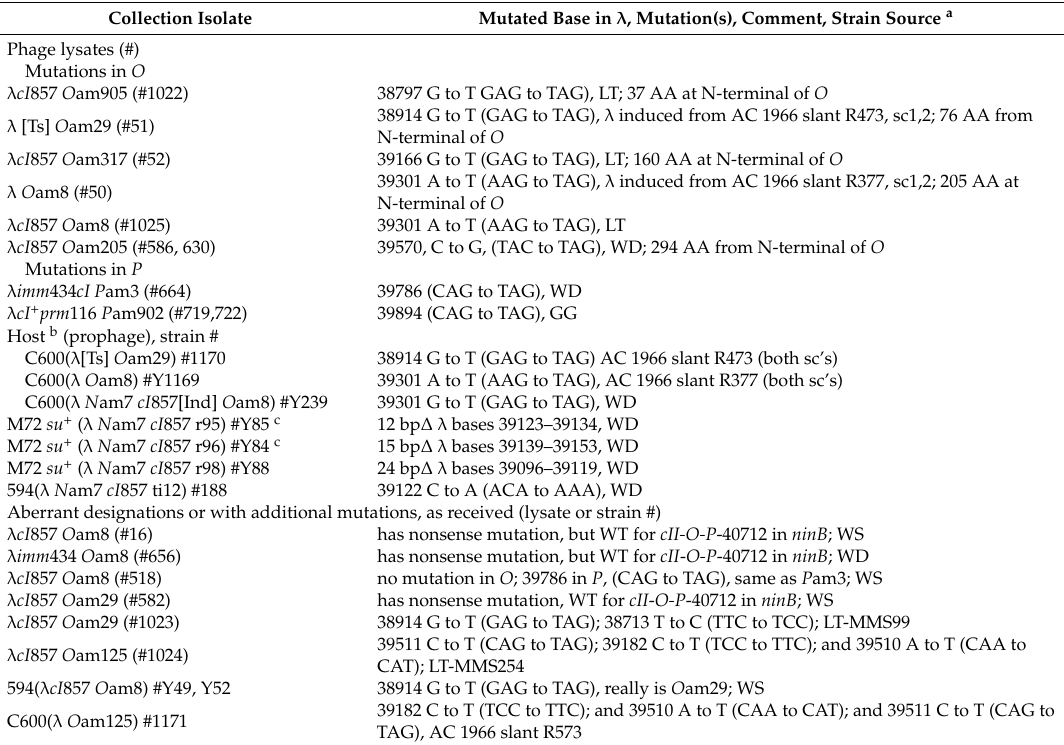
Table 1. Collection of sequenced phage mutants in O and